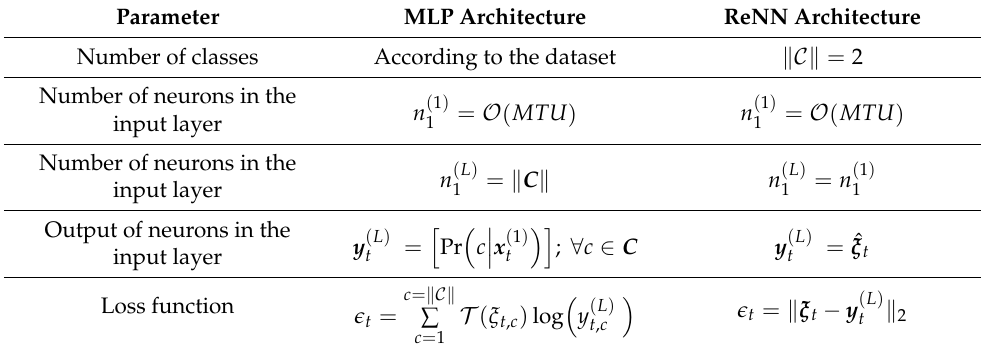
Table 1. Parameters of the initial versions of MLP and ReNN architectures. Parameter MLP Architecture ReNN